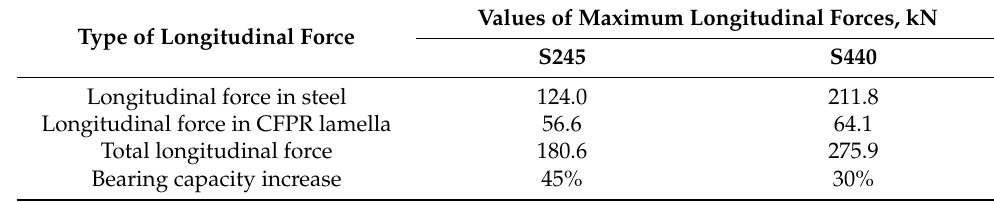
Table 9. Stresses arising in the elements of strengthened specimens made of S245 and S440